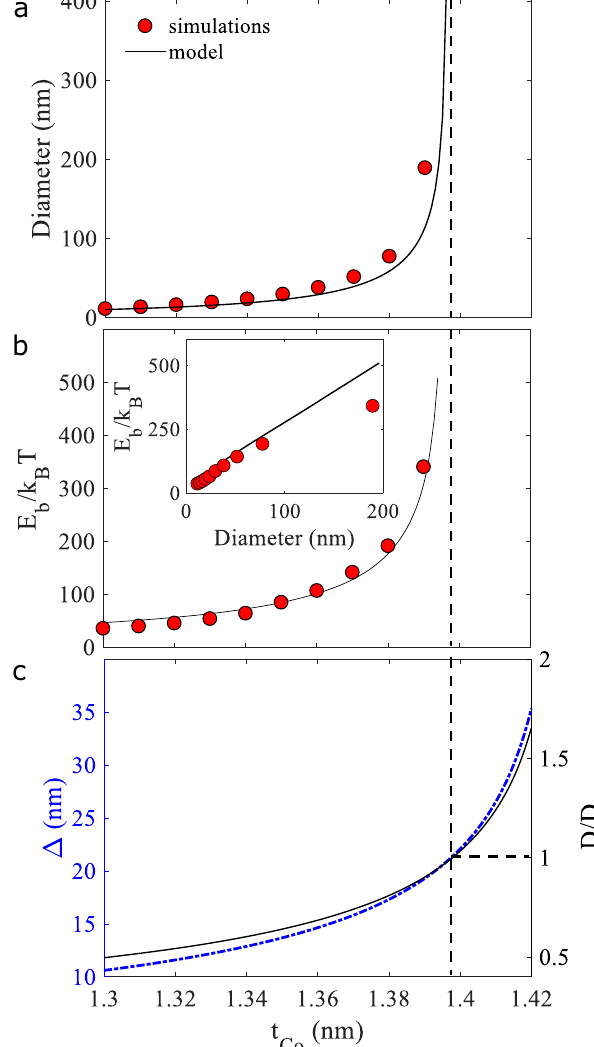
Fig. 3 | Skyrmion size and stability vs fi lm thickness. a Skyrmion diameter and b stability energy E b (in units of k B T with T =300 K) as a function of the Co fi lm thickness t Co predicted by micromagneticsimulations(red dots)and the analytical model (black line). Inset: stability energy vs skyrmion diameter. c Domain wall width Δ and ratio of DMI to criticalDMI D / D c asafunctionofthe Co fi lm thickness. The thickness of the Co/NiFe/Co layer is adjusted at each t Co such that the SAF is always